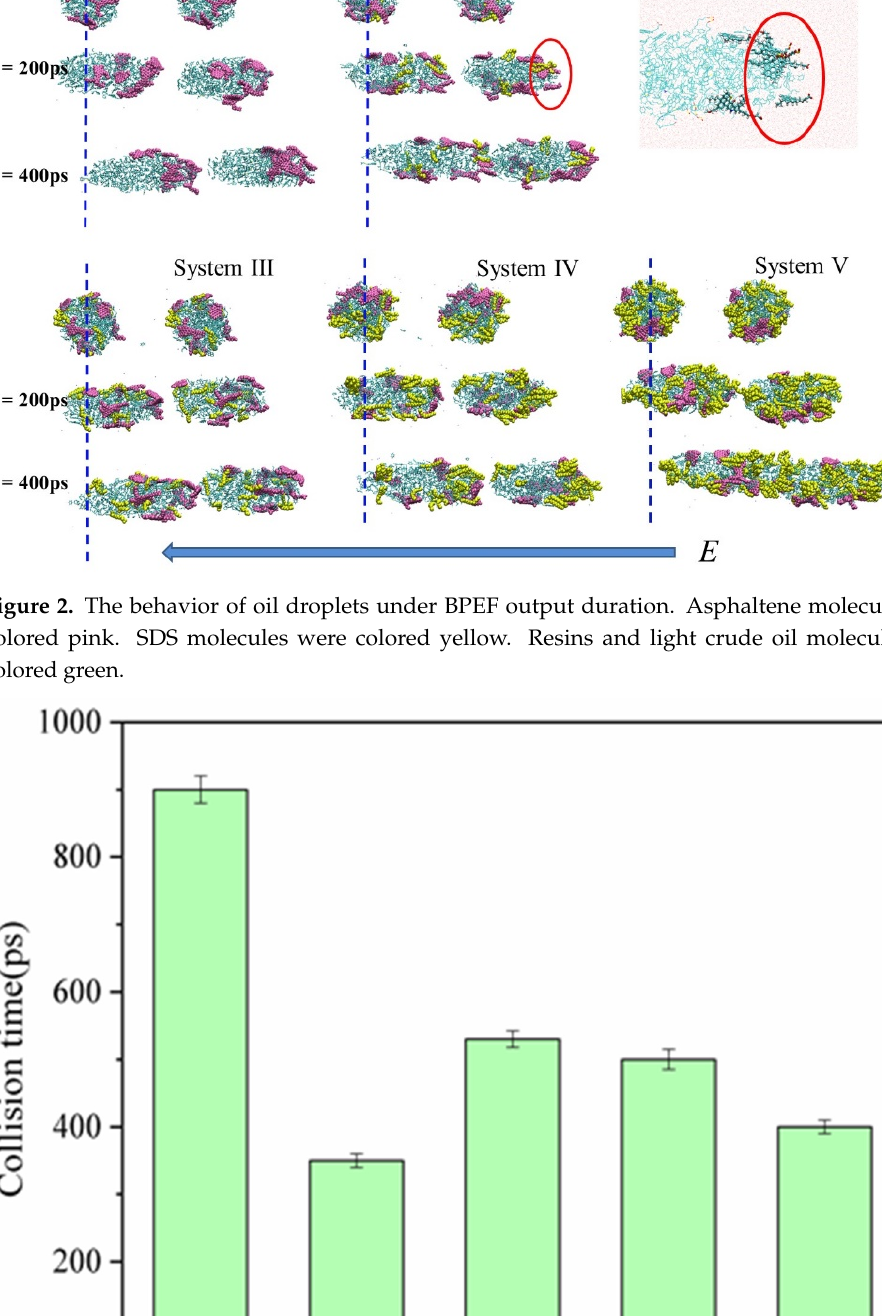
Figure 3. Collision time of oil droplets in five systems under the electric field of 0.5 V/nm.